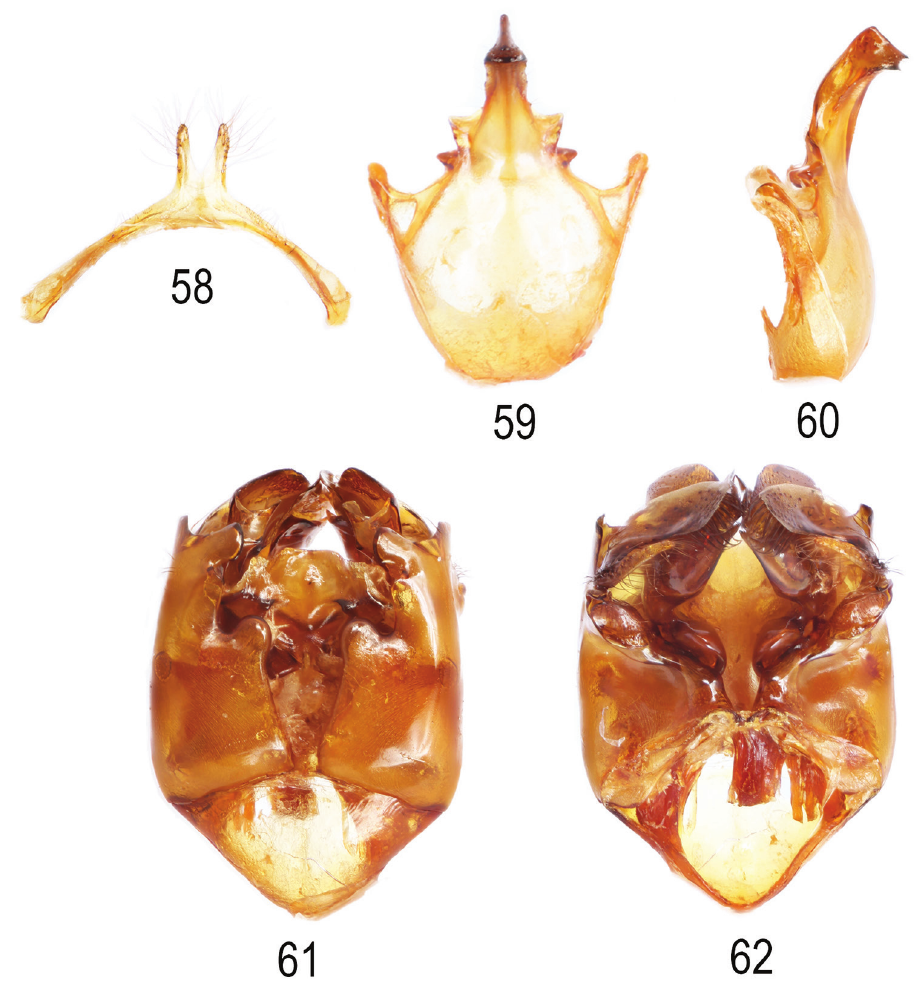
Figures 58–62. Male terminalia of E. oliveri (paratype. Mexico: Guerrero, EMEC 1069134). 58 Seventh metasomal sternum in ventral view 59, 60 Eighth metasomal sternum in ventral and lateral views 61, 62 Geni- tal capsule in dorsal and ventral